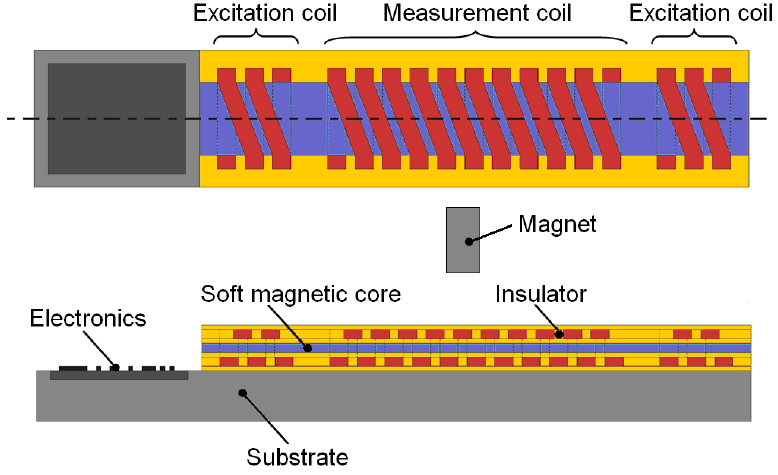
Figure 1. Design model of the Micro-PLCD